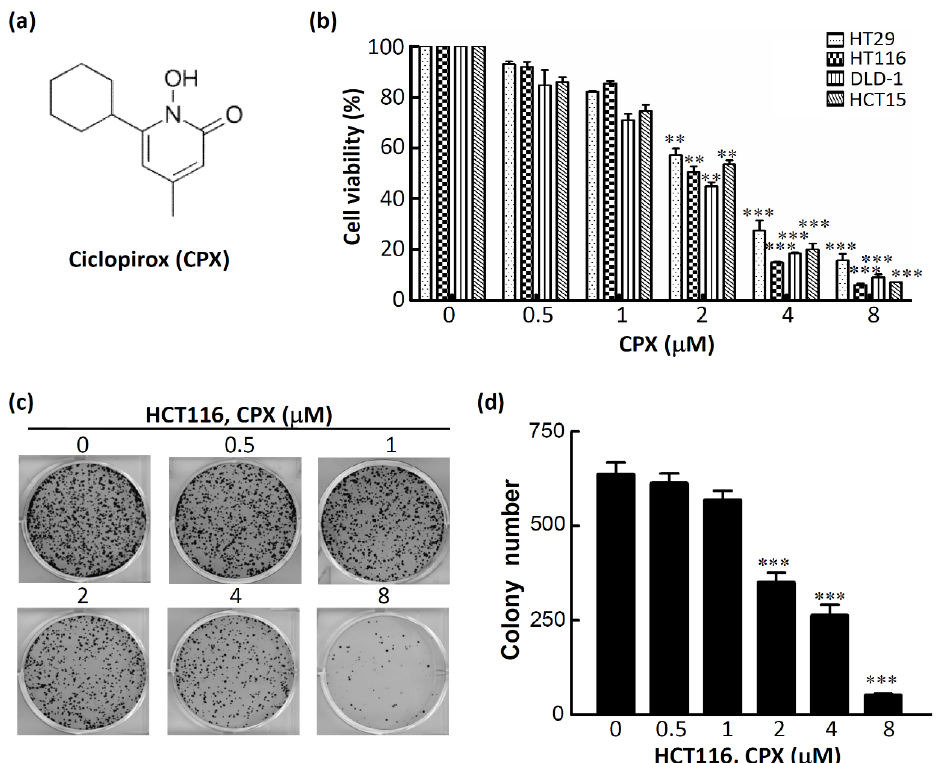
Figure 2. Cytotoxic effect of ciclopirox (CPX) in colorectal cancer (CRC) cell lines. ( a ) Chemical structure of CPX. ( b ) Effects of CPX on the viability of HT29, HCT116, DLD-1, and HCT15 CRC cells. Cells were treated with CPX at the indicated concentrations in 10% fetal bovine serum (FBS)-supplemented medium for 48 h, and cell viability was assessed using the crystal violet staining method. Bars, standard deviation (SD) ( n = 6). ( c ) HCT116 cells were treated with CPX at the indicated concentrations, and foci were visualized after crystal violet staining. ( d ) The quantification of colony number, wherein total colony counts ± SD are illustrated. ** p < 0.01, *** p < 0.001.